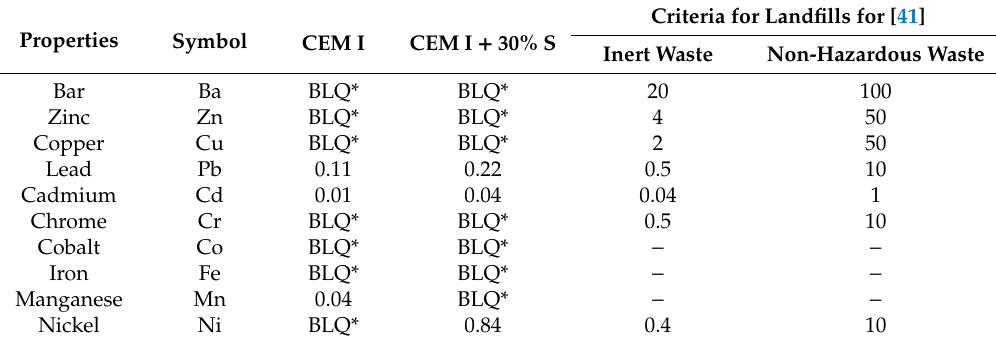
Table 12. Leachability of heavy metals from mortar (integral), expressed in mg / kg.